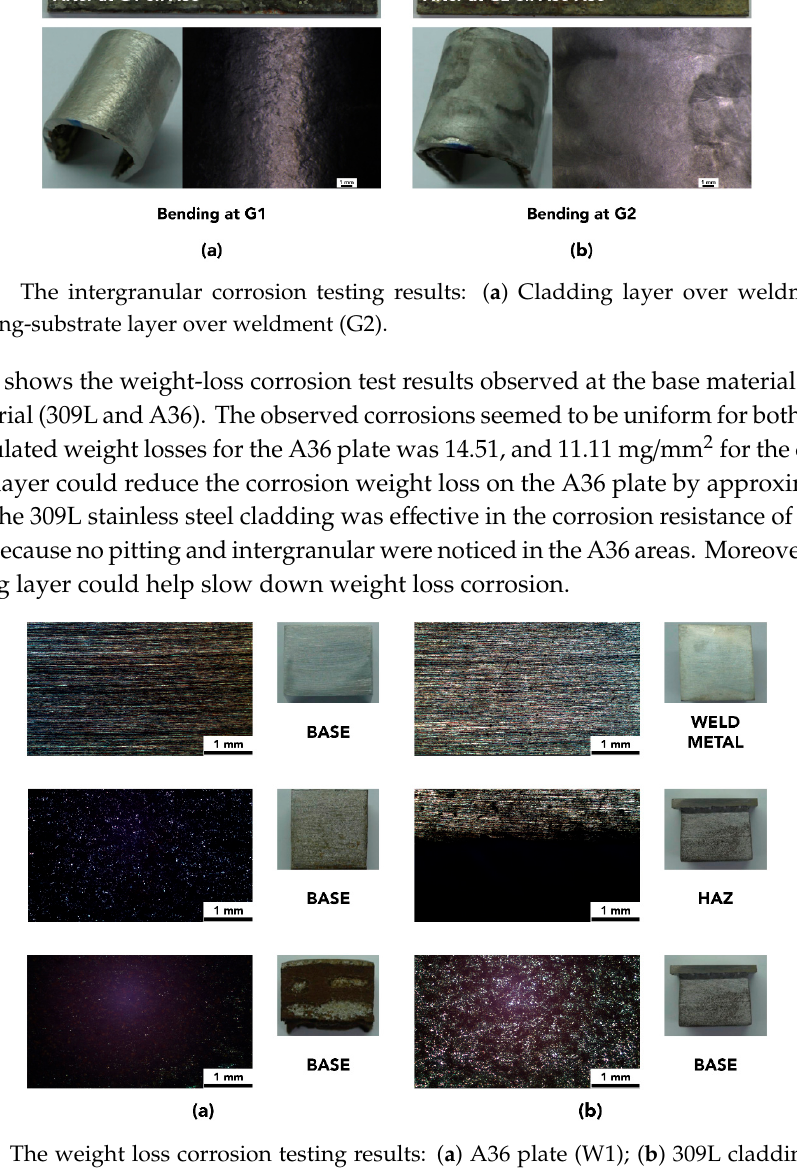
Figure 13. The measured dimensions of the selected pitting location.